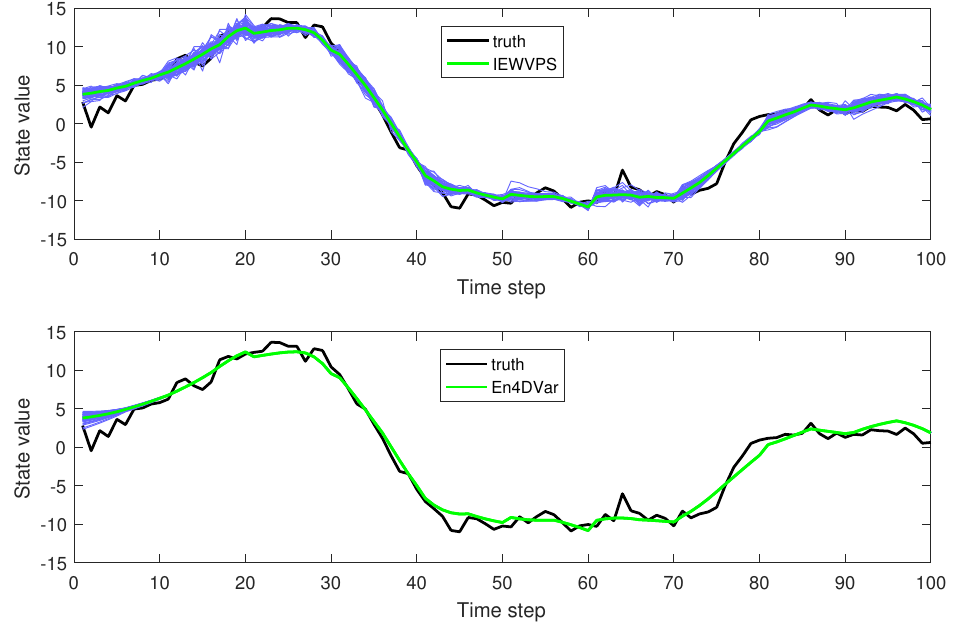
Figure 8. Trajectories of the No. 50 variable during the first 100 model steps . The black line represents truth, blue lines represent the evolution of each particle, and the green line represents the ensemble mean. Experiments are implemented with N x = 100 and N e = 50.